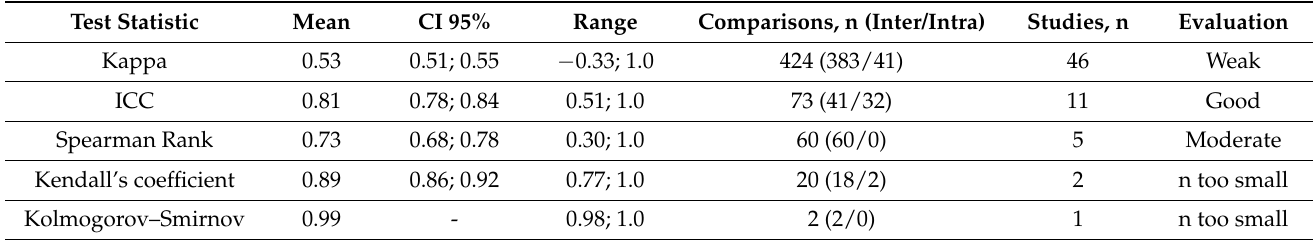
Table 3. Overall means combined inter/intra-observer statistics